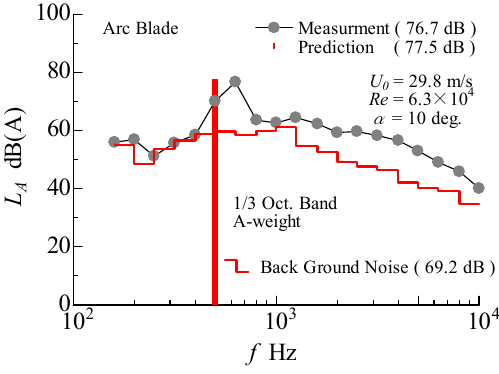
Figure 13 is the spectra of the noise level generated by the arc blade represented by each 1/3 octave band frequency in the A-weight measurement. The angle of attack is set at 10°. The column indicates the predicted spectrum. When the frequency was estimated by the relation of the Strouhal number, the frequency of the noise was estimated at 500 Hz in 1/3 octave band frequency. The measured noise level becomes maximum level at the vicinity of the estimated frequency. Since the measured noise level has approximately 2 dB errors, it is considered that the predicted noise level is slightly underestimated than the measured noise level. It is experimentally proved that the influence of the harmonic component is little in these noise spectra.